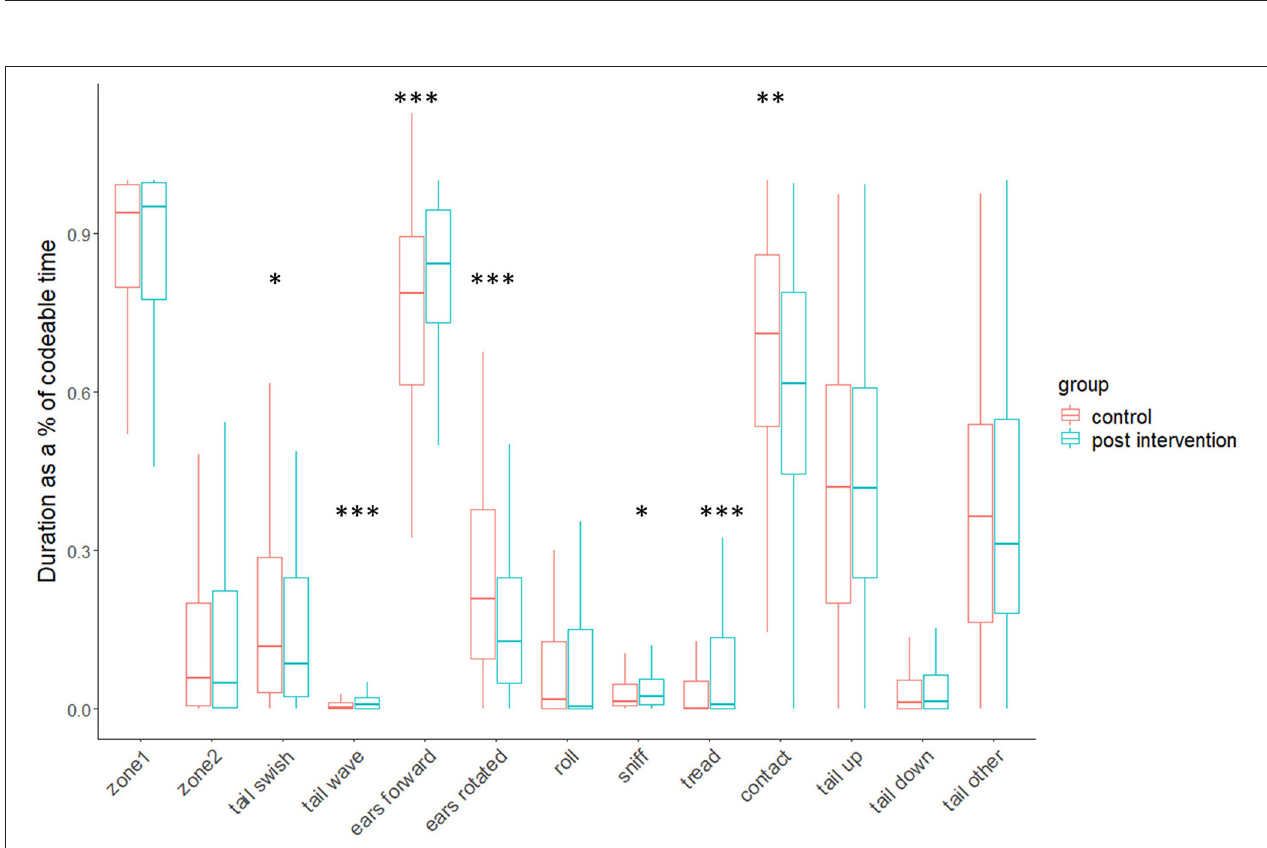
FIGURE 2 | Boxplots of cats’ average (duration based) behavioural responses for control and intervention conditions (* p < 0.05, ** p < 0.01, *** p < 0.001).